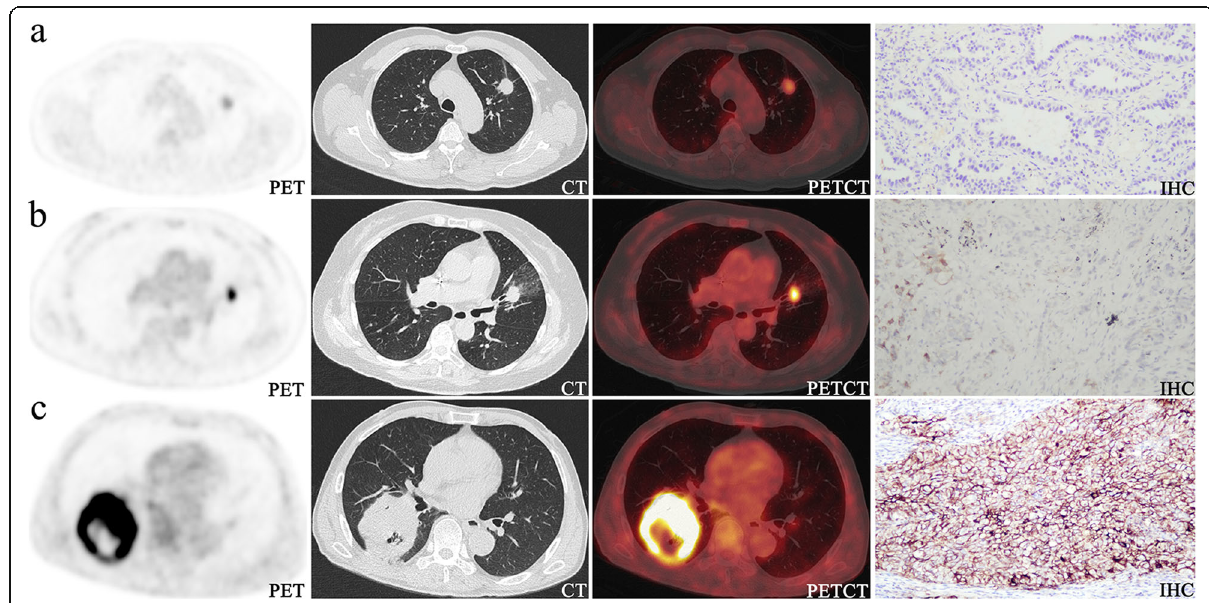
Fig. 2 Representative PET, CT, fused, and immunohistochemistrical (IHC, ×100) pictures. a A 61-year-old man with left lung AC had an SUVmax of 4.9 and negative PD-L1 expression. b A 66-year-old woman with left lung AC had an SUVmax of 11.6 and positive PD-L1 expression during 1 –